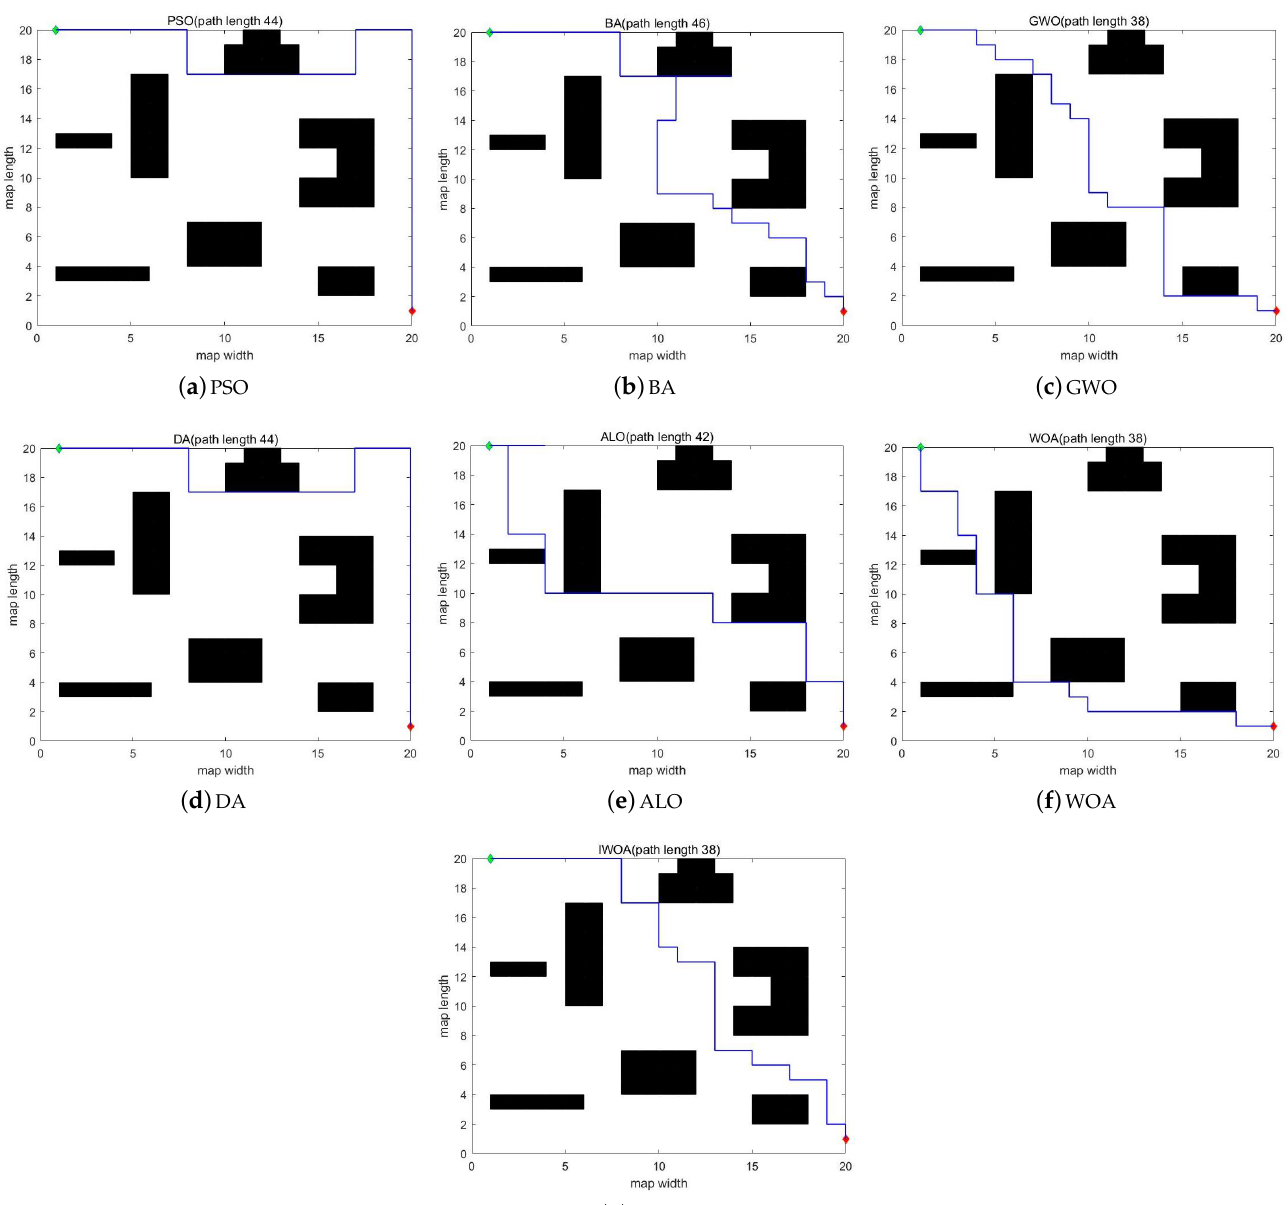
Figure 12. Actual path traces of seven different algorithms on 20 × 20 size